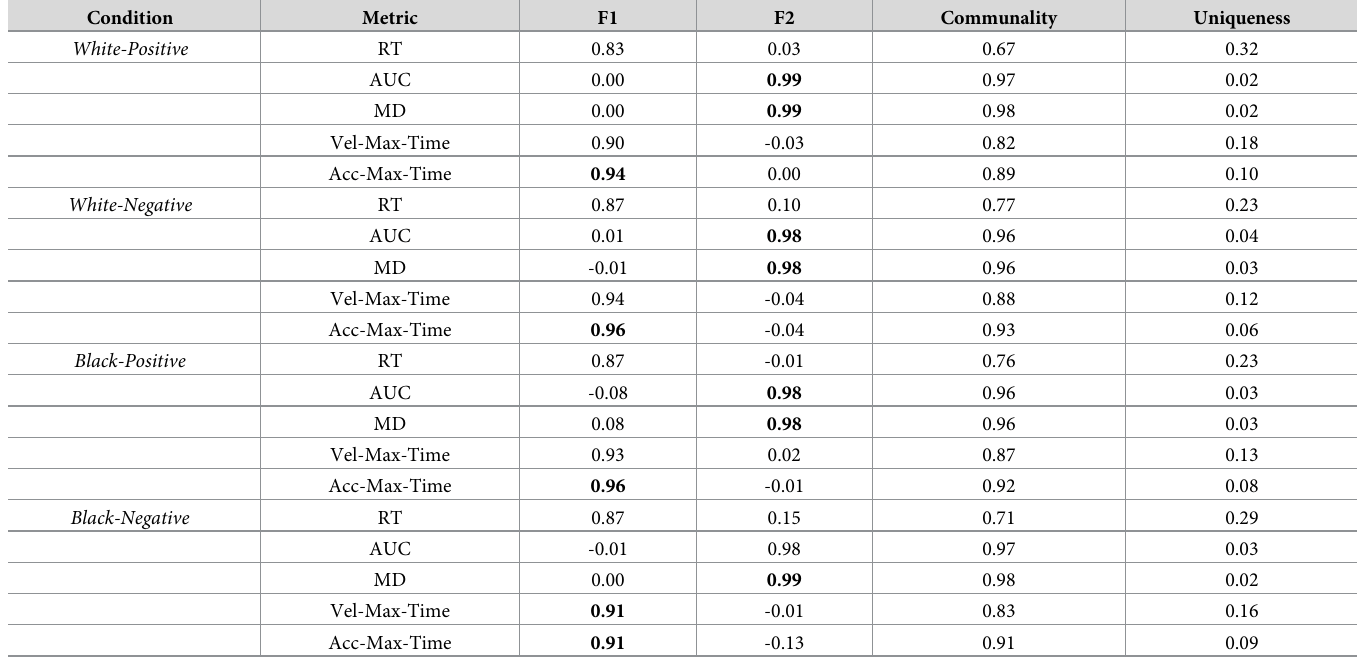
Table 4. Saturation in each factor, communalities, and uniqueness of all the metrics included in the PCAs run for each condition. Condition